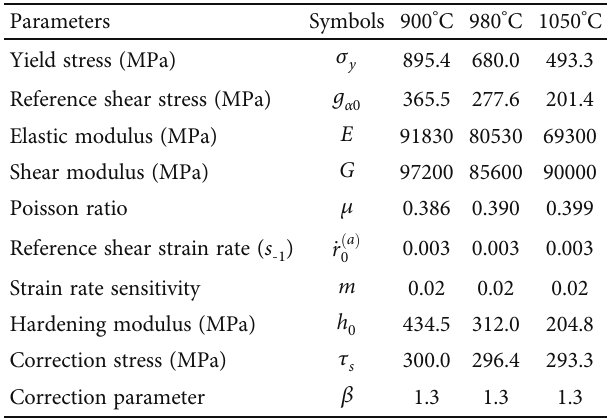
Table 2: Model parameters.